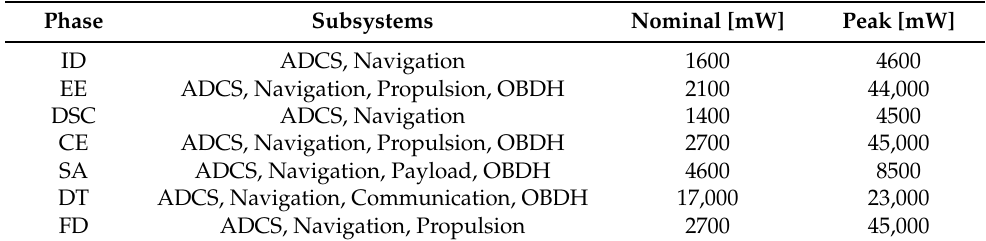
Table 6. Power budgets of mission phases, based on components